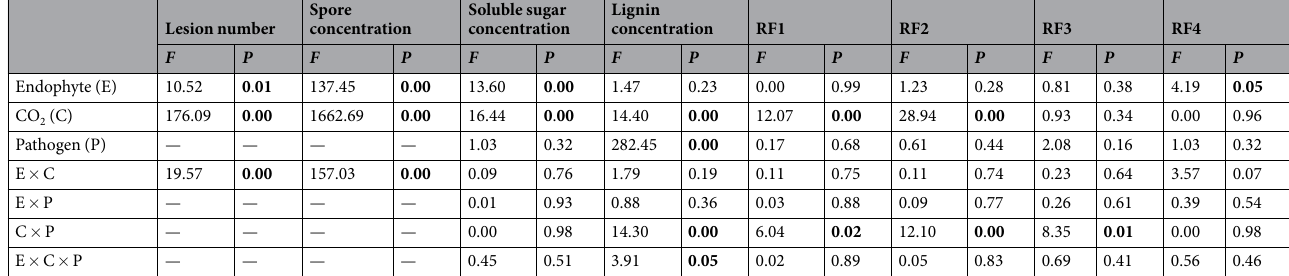
Table 2. Three-way ANOVA for pathogen and physiological indices of endophyte-infected (E + ) or uninfected